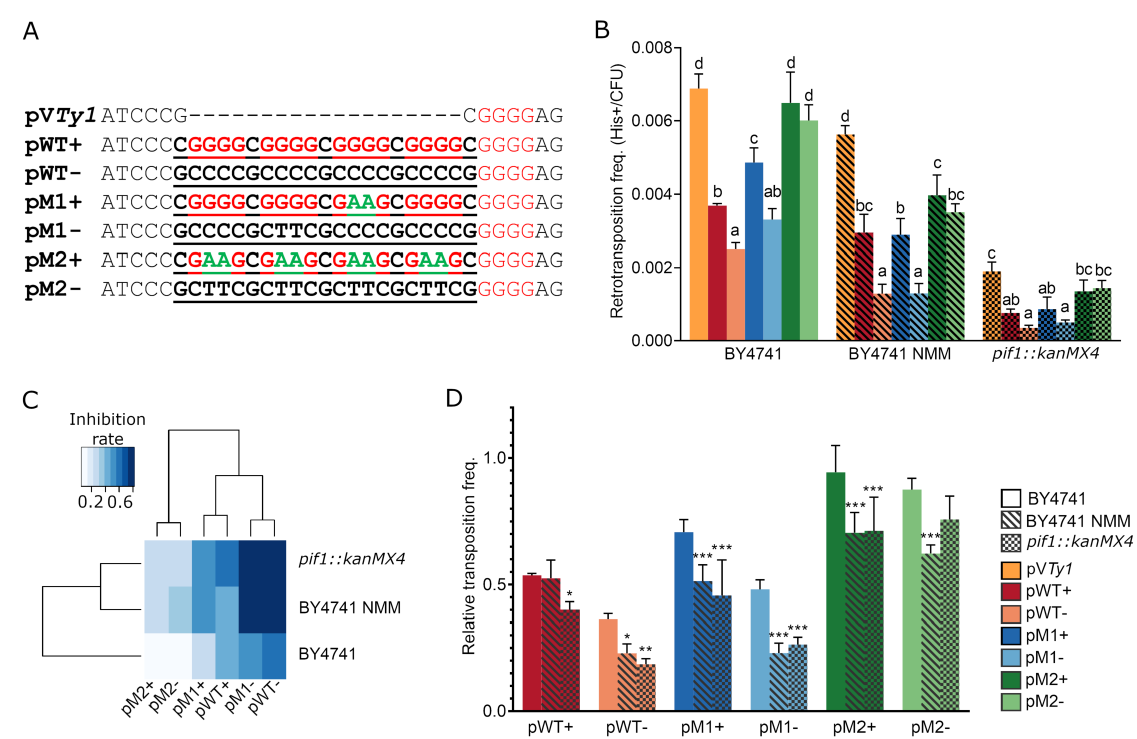
Figure 4. Frequency of Ty1his3-AI retrotransposition. ( A ) Sequences cloned (underlined) into SacII recognition site located in 3 (cid:48) UTR of Ty1his3-AI . Guanine blocks are highlighted by red and G to A substitutions by green color. ( B ) Absolute retrotransposition frequency of Ty1his3-AI (pV Ty1 ) containing G-quadruplexes (pWT and pM1) as well as control sequences (pM2), demonstrate the inhibitory effect of G4s as well as Pif1p deficiency and NMM treatment. Columns represent mean ± SD ( n = 3–4 colonies) of retrotransposition frequency. Significantly different transposition frequencies within each treatment/yeast strain are indicated by different letters. (One way ANOVA, Tukey’s HSD test; p ≤ 0.05). ( C ) Heatmap of inhibitory effect of inserted sequences combined with NMM treatment and Pif1p deficiency on retrotransposition. ( D ) Relative Ty1his3-AI retrotransposition frequency normalized to pV Ty1 revealing an inhibitory effect of NMM treatment or Pif1 helicase deficiency ( pif1::kanMX4 ). Statistical differences are with respect to BY4741 (One way ANOVA,